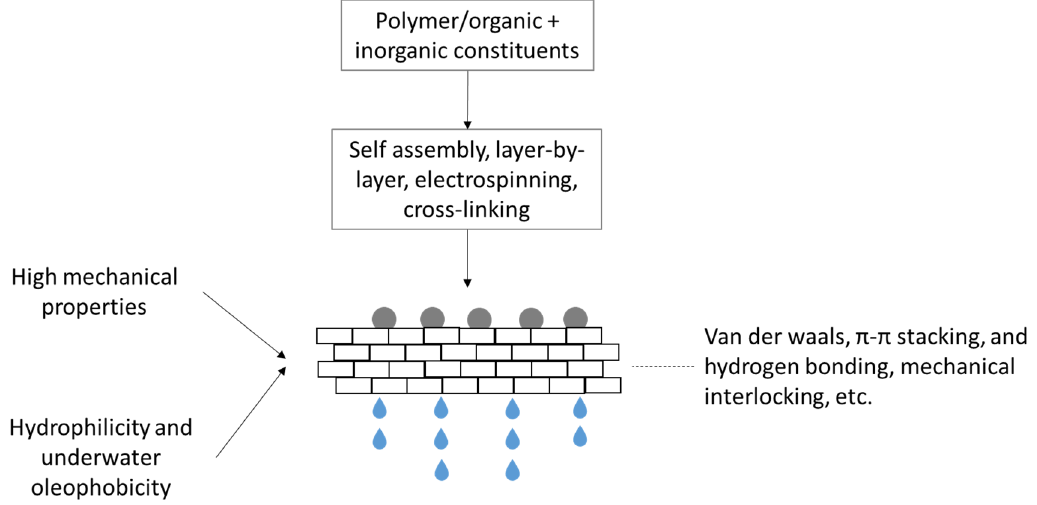
Figure 7. Illustration of the synthesis and interaction of organic and inorganic constituents in layered composites for oil–water separation.